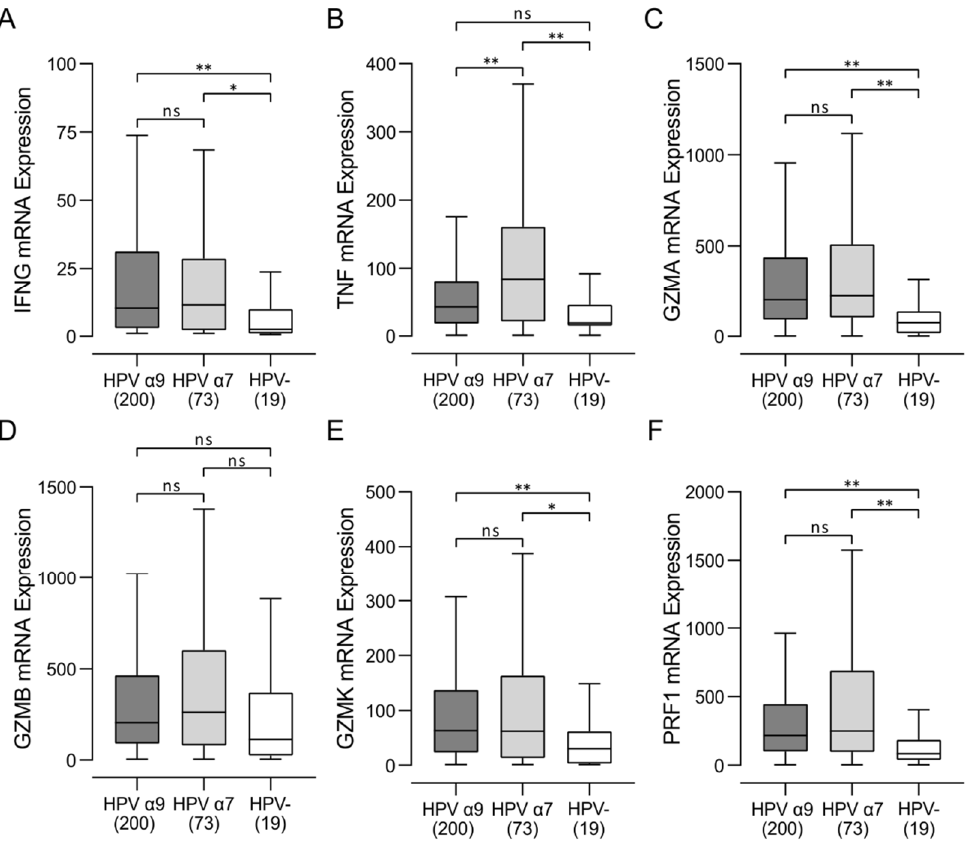
Figure 4. Transcript levels of lymphocyte effector molecules in HPV-positive (HPV α 9 and HPV α 7) and HPV-negative (HPV-) cervical cancers. ( A – F ) Expression of marker genes related to activated cytotoxic CD8 + T cells, including IFN- γ (IFNG), TNF- α (TNF), granzyme A (GZMA), granzyme B (GZMB), granzyme K (GZMK), and perforin (PRF1). Numbers in brackets refer to the number of samples included in each analysis. ** p ≤ 0.01, * p ≤ 0.05, ns (not significant).